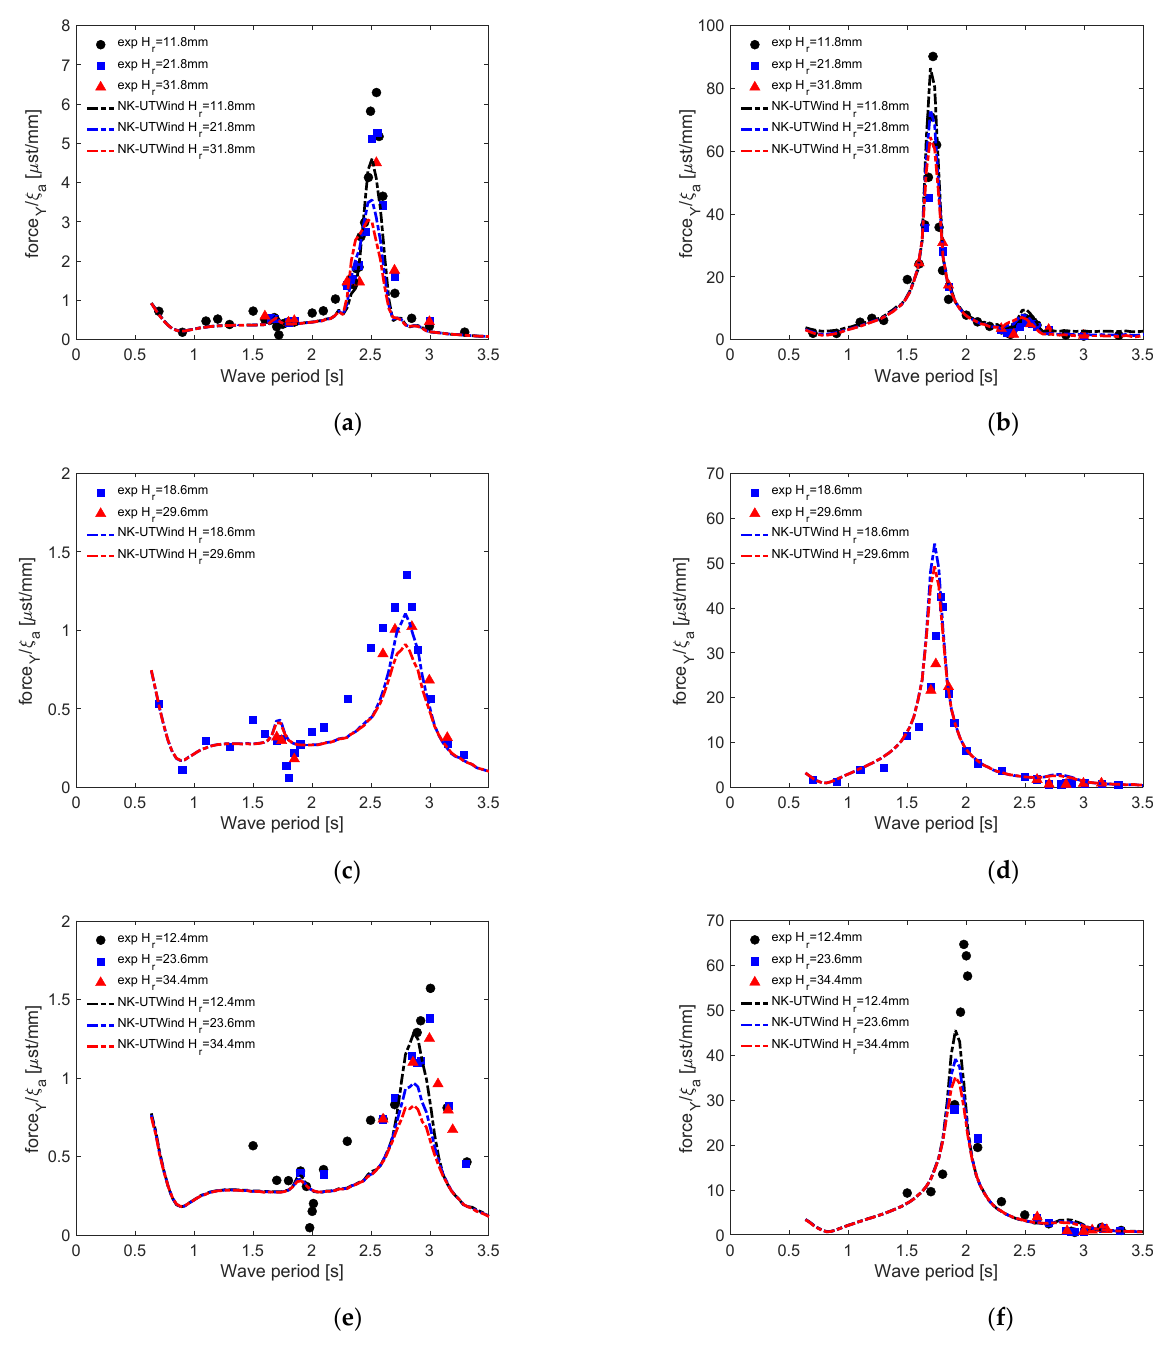
Figure 14. Response amplitude operator (RAO) strain result comparisons between the experiment and NK-UTWind numerical calculations and different wave heights for strain around the Y -axis at the tower base: ( a ) Sphere, ( c ) Plate, and ( e ) Semi-spheroid models; and for strain around the Y -axis at the deck: ( b ) Sphere, ( d ) Plate, and ( f ) Semi-spheroid models. For the RAO strain at the tower base, the peak around 2.7 s corresponded to the natural period of the pitch. The peak height was about 20% that of the Sphere model, which the lower response of pitch motion can explain. In NK-UTWind, a small peak was observed at the Eigen period of the elastic mode. However, the peak value was smaller in the experiment. At the deck, the period of the peak in the experiment corresponding to the Eigen period of the elastic mode, 1.78 s, and the NK-UTWind were in good agreement with the